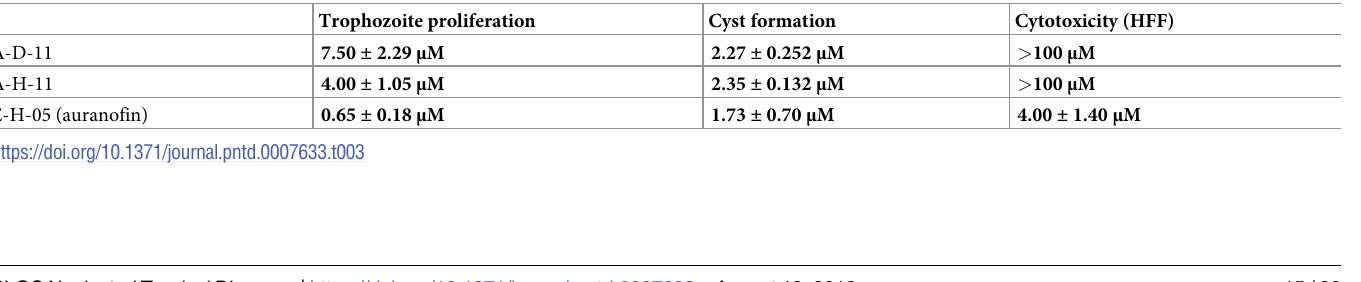
Table 3. Summary for IC 50 values of A-D-11, A-H-11, and E-H-05 (auranofin) for processes crucial in Entamoeba life cycle and for human cell. IC 50 values for tro- phozoite proliferation, cyst formation, and human cell were determined by three independent experiments and expressed as average ± SD. IC 50 values of E-H-05 for these processes were from